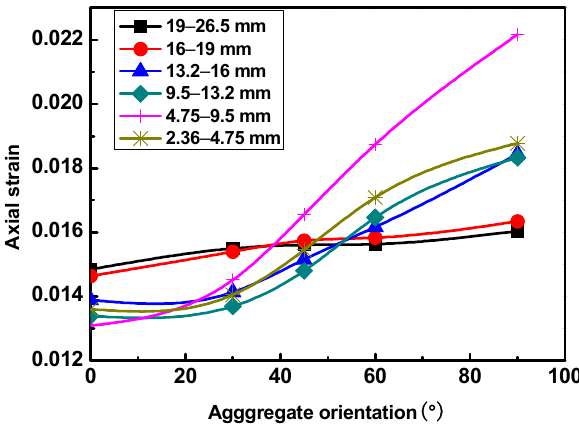
ff erent aggregate